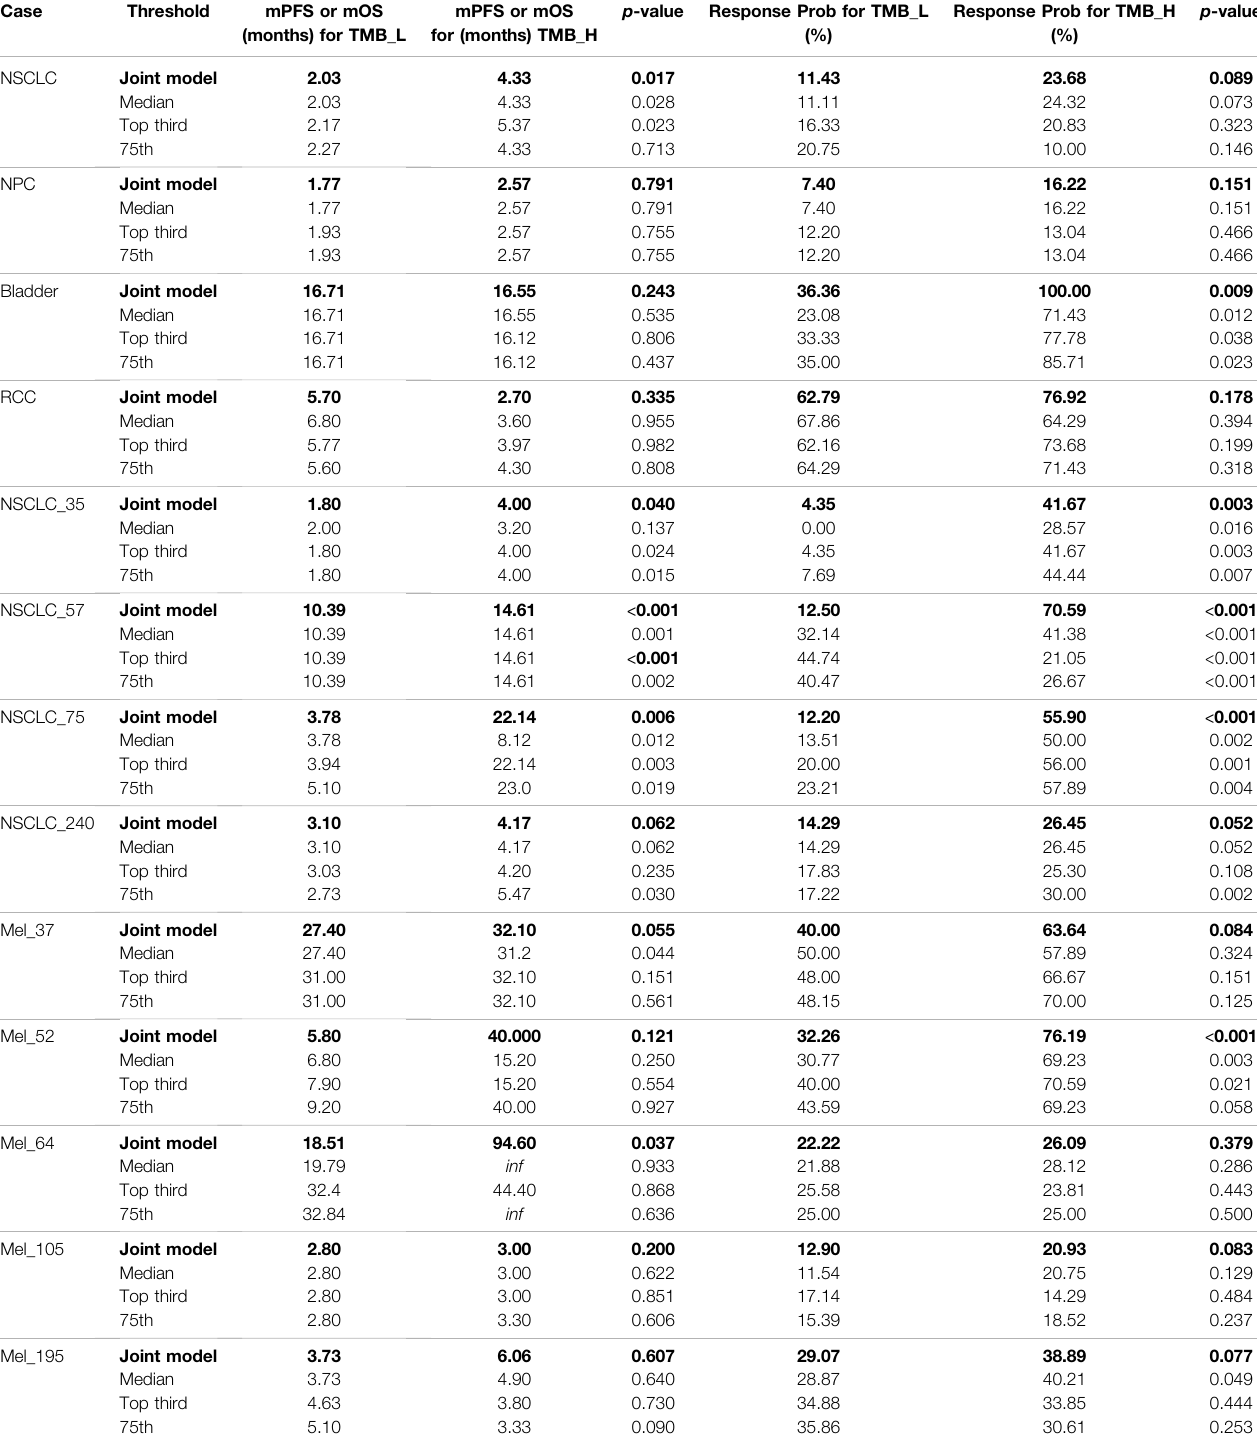
Bold values represent the results of the proposed joint